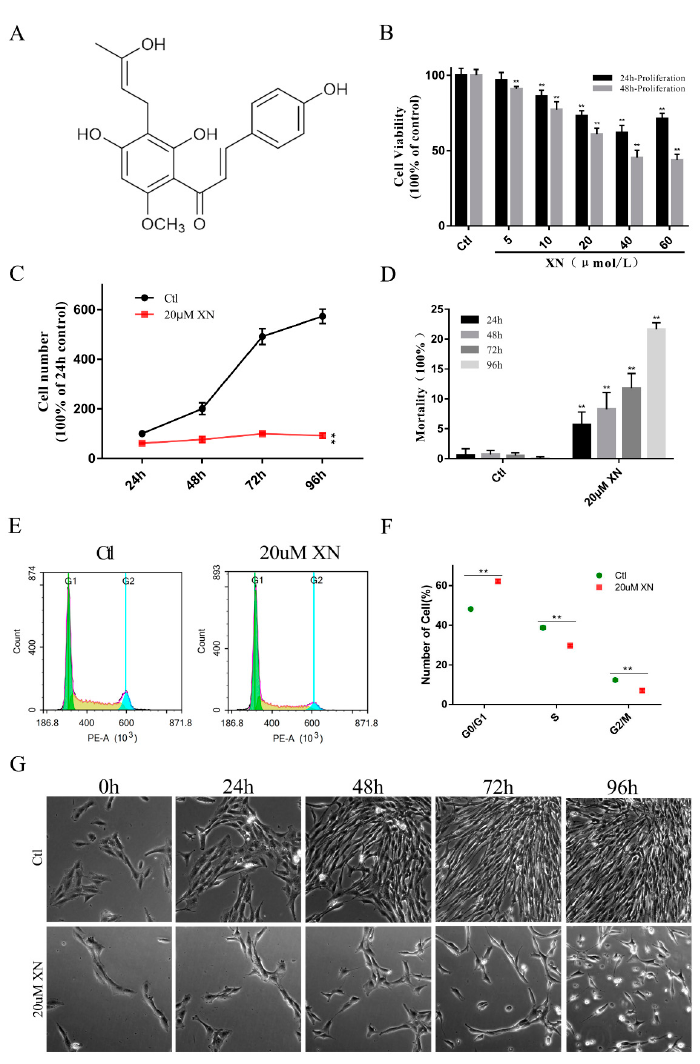
Figure 1. Effects of XN on proliferation activity and morphology of C6 cells. ( A ) The formula for XN. ( B ) The C6 cells were treated with XN for indicated concentration and time, and the cell viability